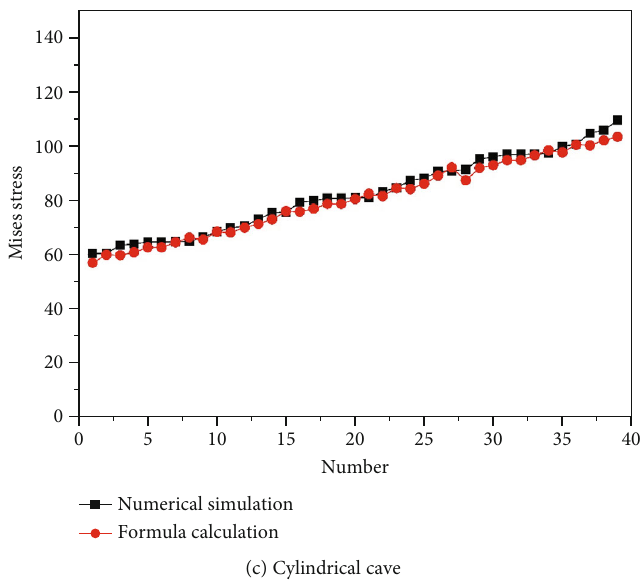
Figure 9: Numerical simulation curve and fi tting curve for a single cave.